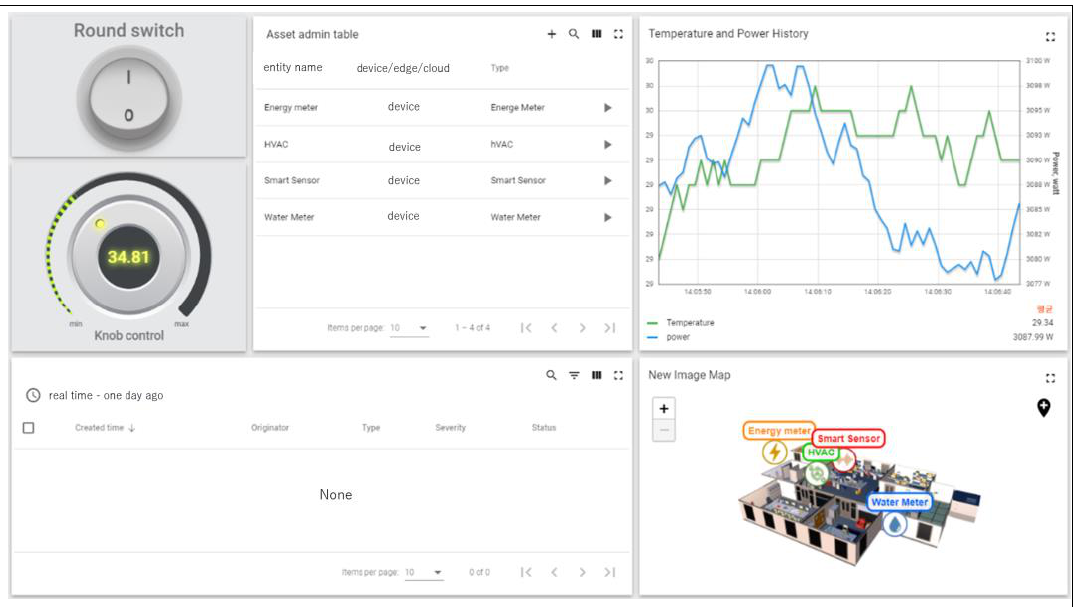
Figure 9. Temperature Sensor data collected at every period.